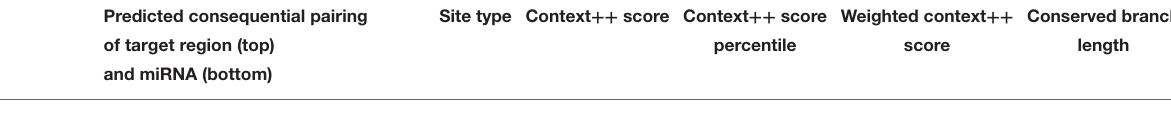
TABLE 1 | The predicted consequential pairing site between ER α and miR-452. Predicted consequential pairing